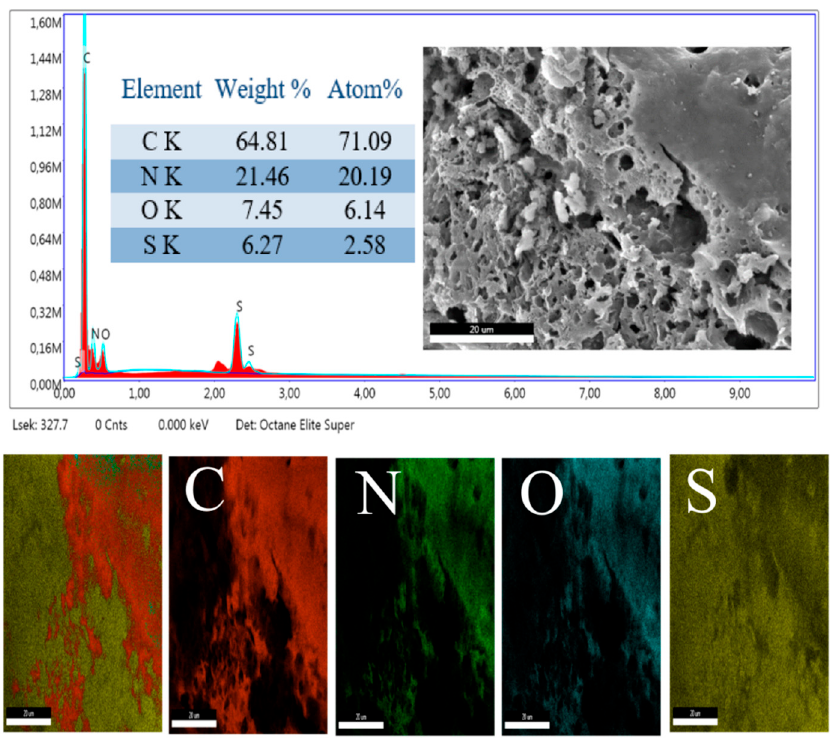
Figure 3. Elemental composition and SEM–EDX spectrum of the PANI–DBSA sample, along with the mapping of the elements on the polymer surface.